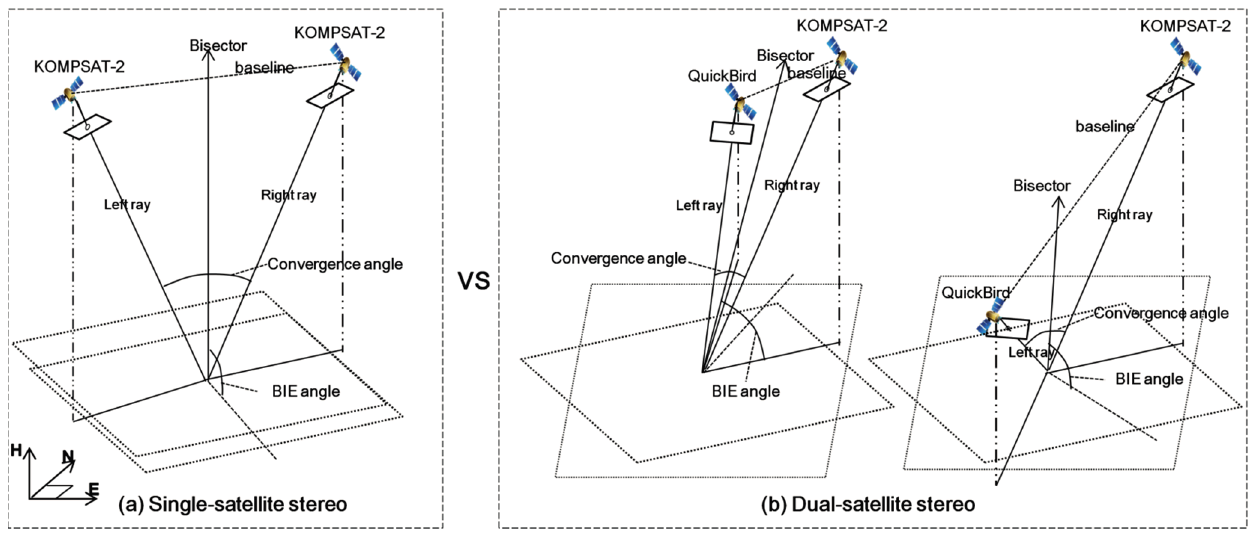
Figure 3. Test cases for comparison between single-satellite stereo and dual-satellite integration. ( a ) single-satellite stereo, ( b ) dual-satellite